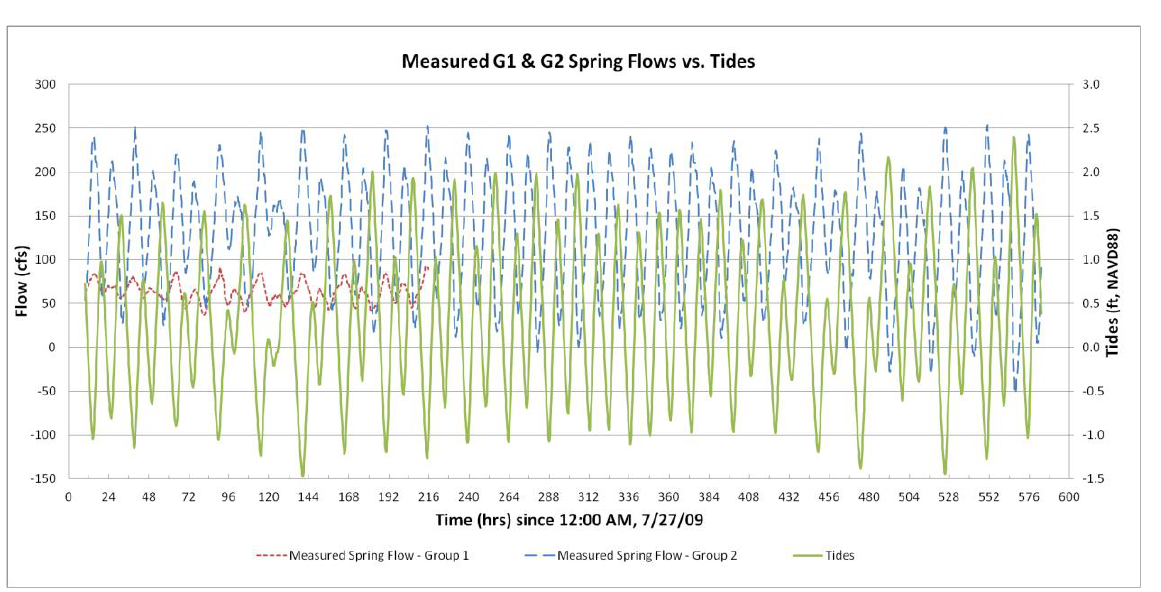
Figure 3. Measured spring flows for Group 1 (red short dashed line) and Group 2 (blue long dashed line) during 27 July–20 August 2009. The green solid line is measured water level at the USGS mouth of Kings Bay station during the same